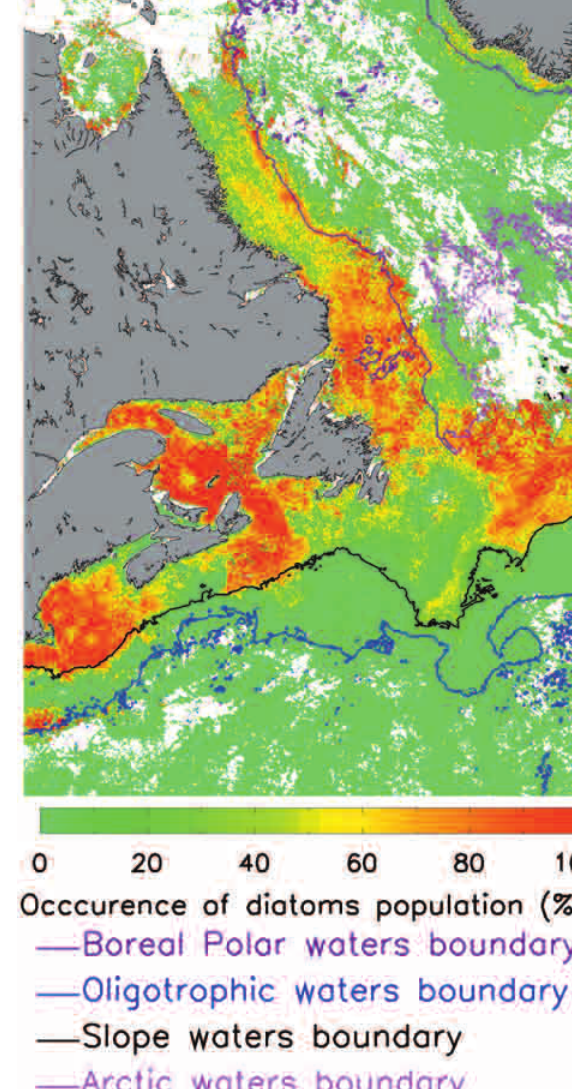
Fig. 11. – Composite image of identification of diatoms during autumn. Solid lines correspond to the province